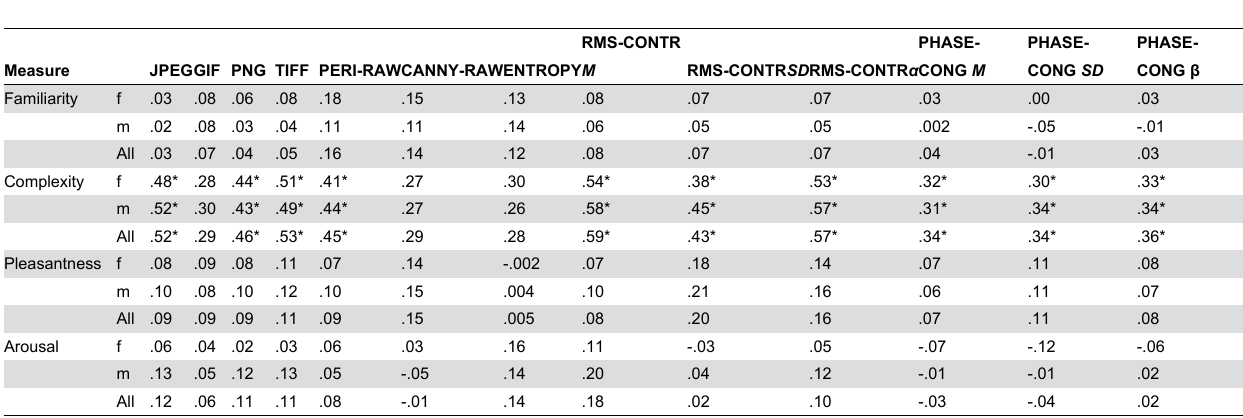
Table 3. Spearman’s rank-order correlations between a set of 13 measures of objective complexity applied to IAPS pictures (N = 96) and ratings of familiarity, complexity, pleasantness and